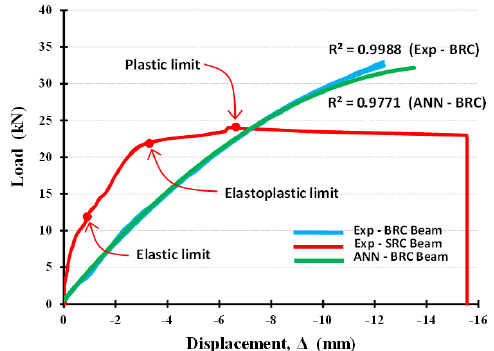
Figure 15. The load vs. deflection relationship the experimental results and ANN analysis.